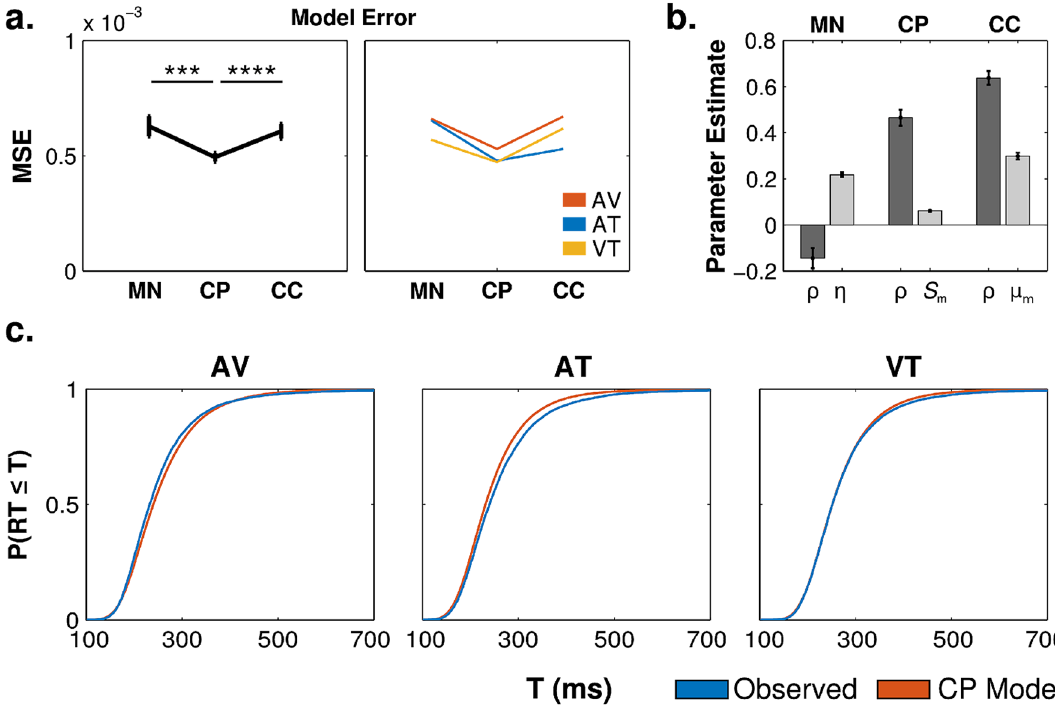
Figure 7. Multisensory model comparisons. ( a ) Mean squared error (MSE) for each model fit, averaged across subjects. The best-fitting CP model exhibited significantly less error than best-fitting MN and CC models. Error bars represent bootstrapped (10,000 samples) within-subjects SEM (i.e., the mean MSE for each subject was subtracted before sampling). ( b ) Best-fitting parameters for each model, averaged across subjects. Errors bars represent bootstrapped SEM (10,000 samples). ( c ) Empirical RT distributions (blue) and CP model predictions (orange), averaged across